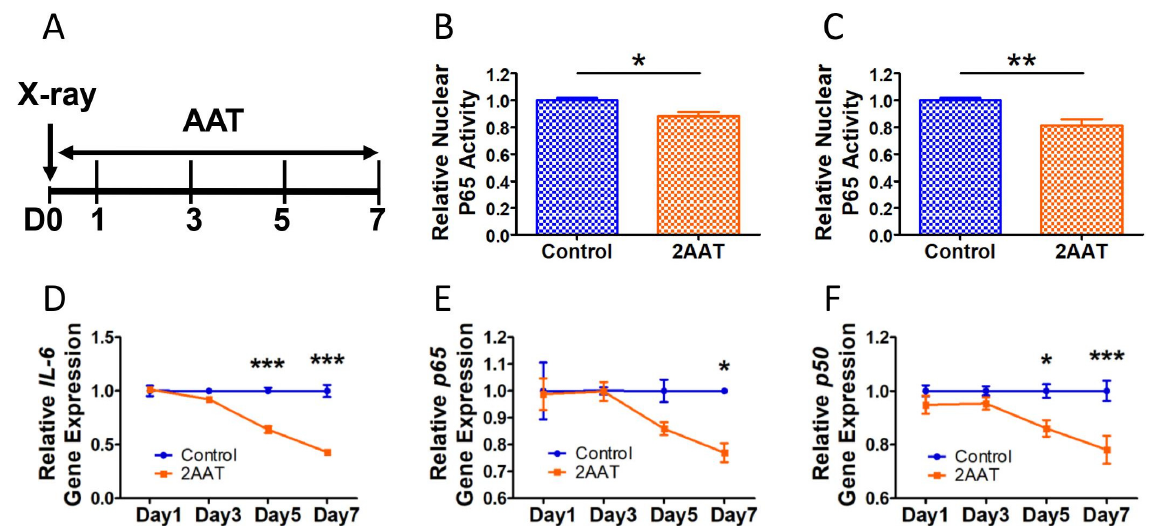
Figure 2. Human AAT inhibited NF- κ B activity before affecting its gene expression in senescent HCA2 cells. ( A ) Study strategy: the HCA2 cells were irradiated and immediately treated with either hAAT (2 mg/mL) or 1 × PBS containing fresh medium. The mRNA or nuclear extraction were conducted at 1, 3, 5, and 7 days after irradiation. ( B ) Relative nuclear p65 activity 3 days after irradiation (N = 4, representative data from 2 experiments). ( C ) Relative nuclear p65 activity 5 days after irradiation (N = 6, representative data from 2 experiments). Gene expression of IL-6 ( D ), p65 ( E ), and p50 ( F ). Error bar represents standard error of the mean. N = 4 for all gene expression data. A T -test was used for statistical analysis. * p < 0.05, ** p < 0.01, *** p < 0.001. To test the effect of hAAT on postsenescent cells, the irradiated cells were cultured for 7 days without any treatment to allow the senescence process to complete. Then, the postsenescent cells were treated with culture medium plus hAAT or PBS for 5 days (until